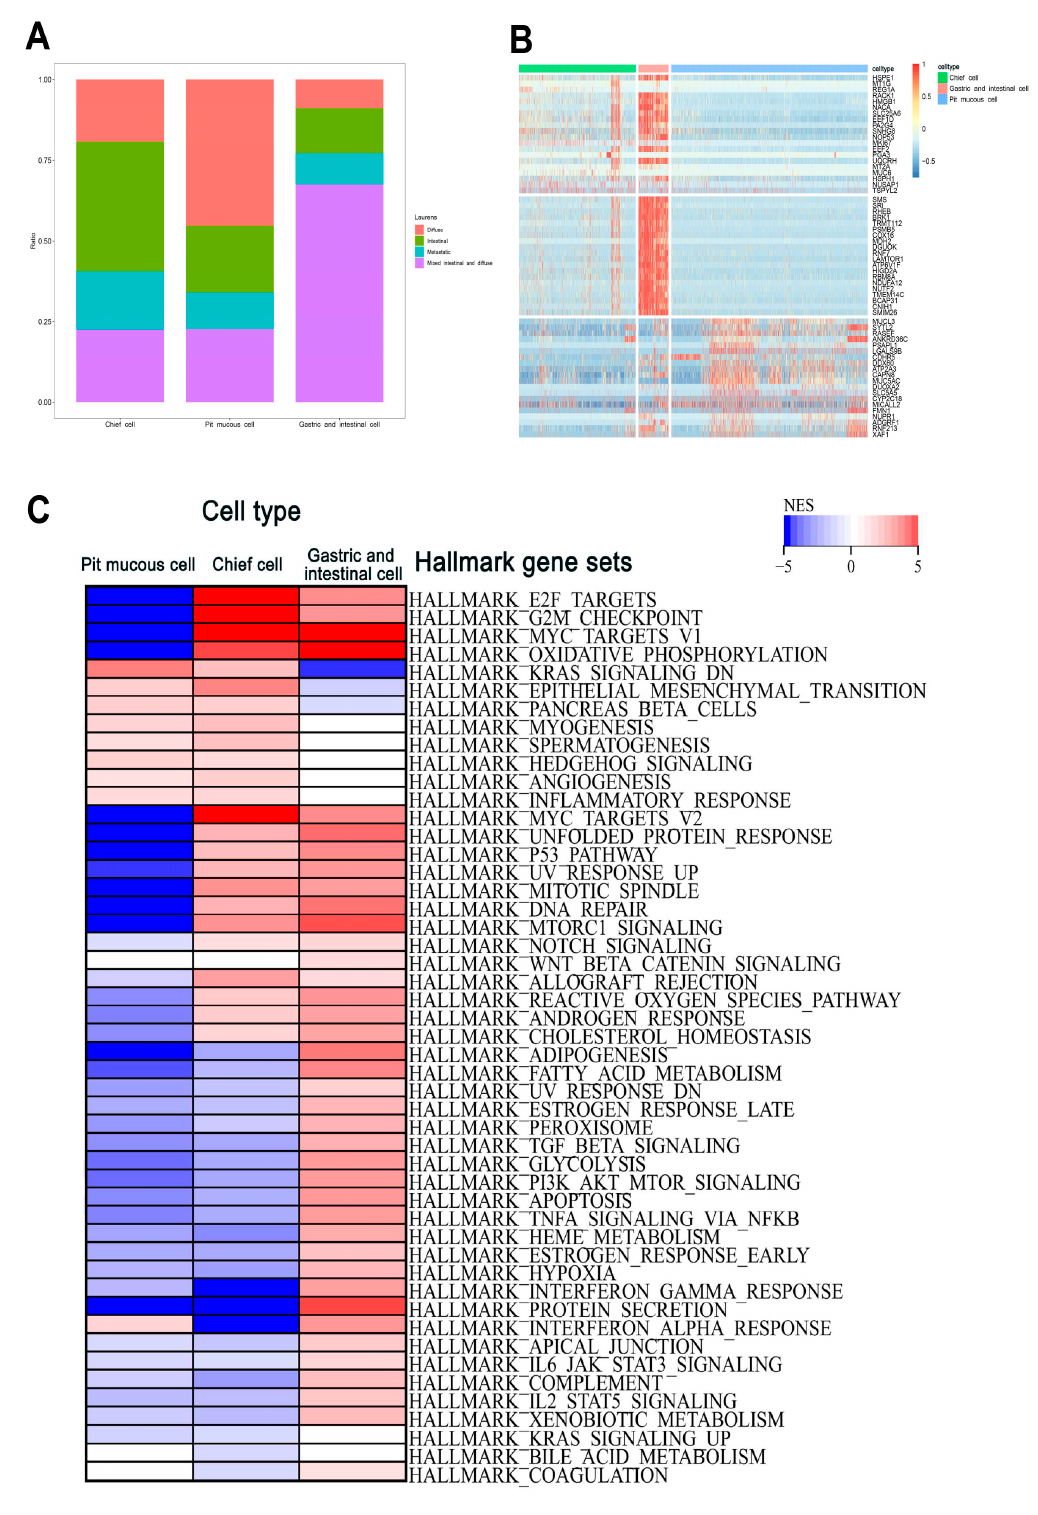
Figure 6. The heterogeneity of the malignant epithelial cell subtypes in GC. ( A ) The proportion of each subtype in Lauren’s histopathology. ( B ) Heatmap showing the top 20 marker genes in three subtypes. ( C ) The GSEA results showing the enrichment gene sets in three